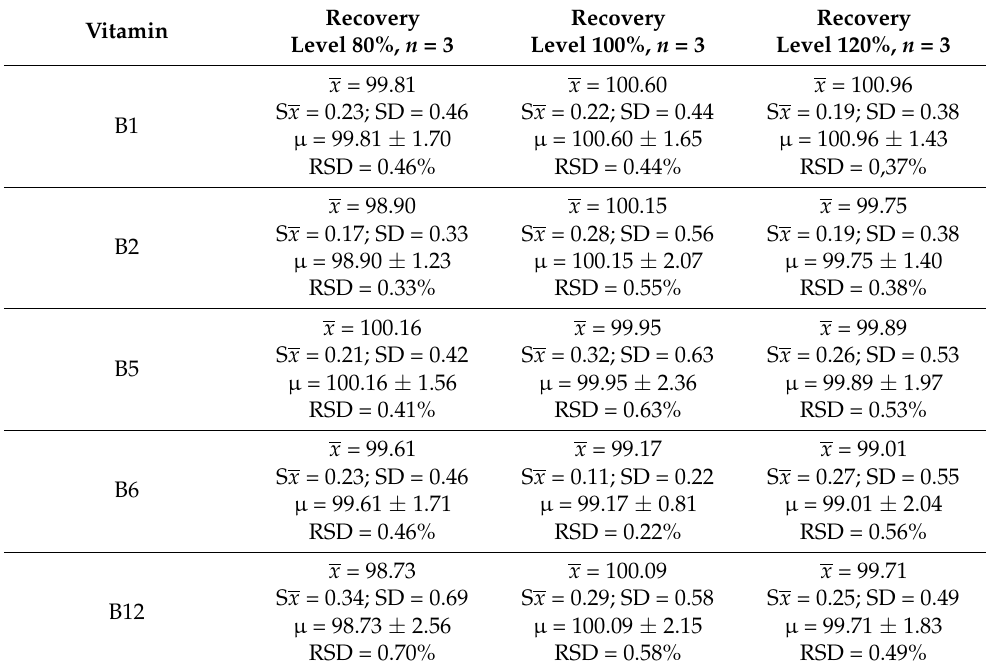
Table 3. The results of the accuracy of the determination of B vitamins with statistical evaluation.